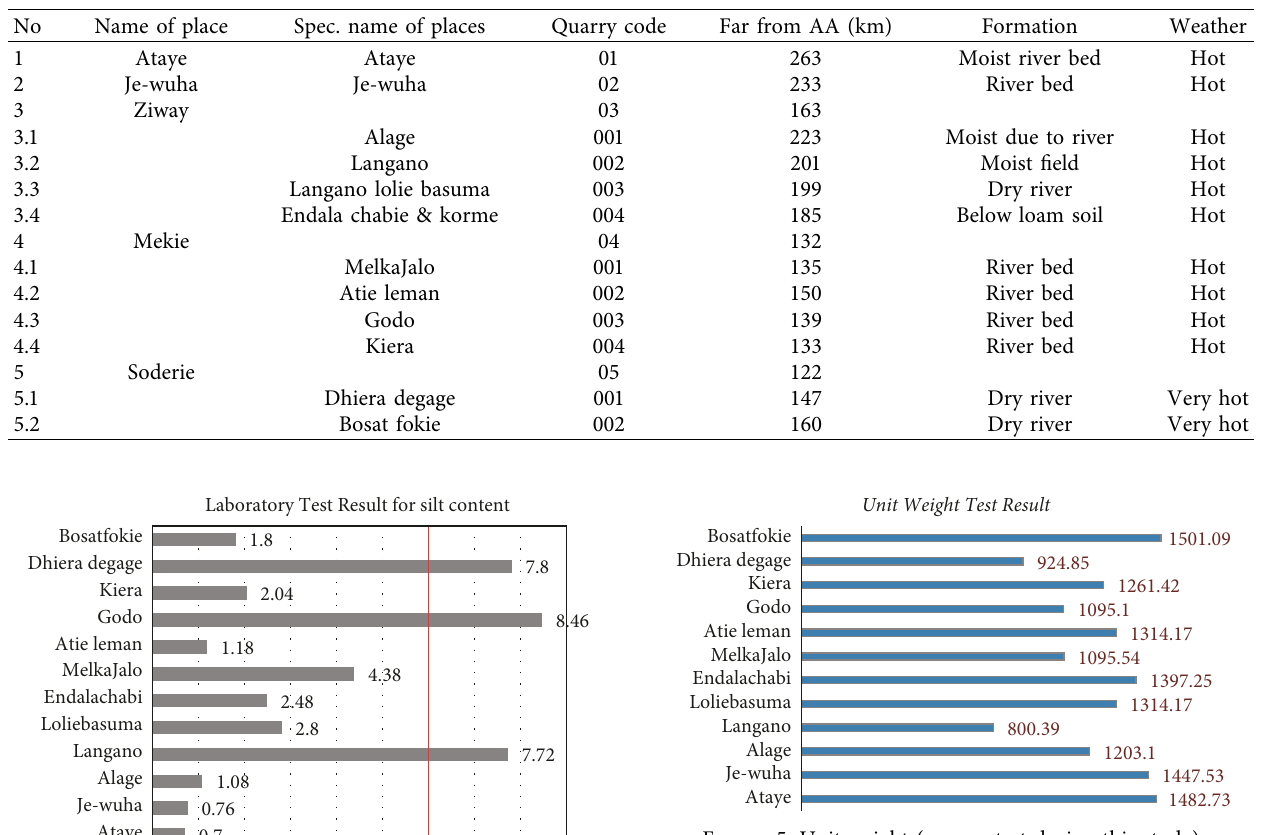
Table 1: Site description of quarry area.